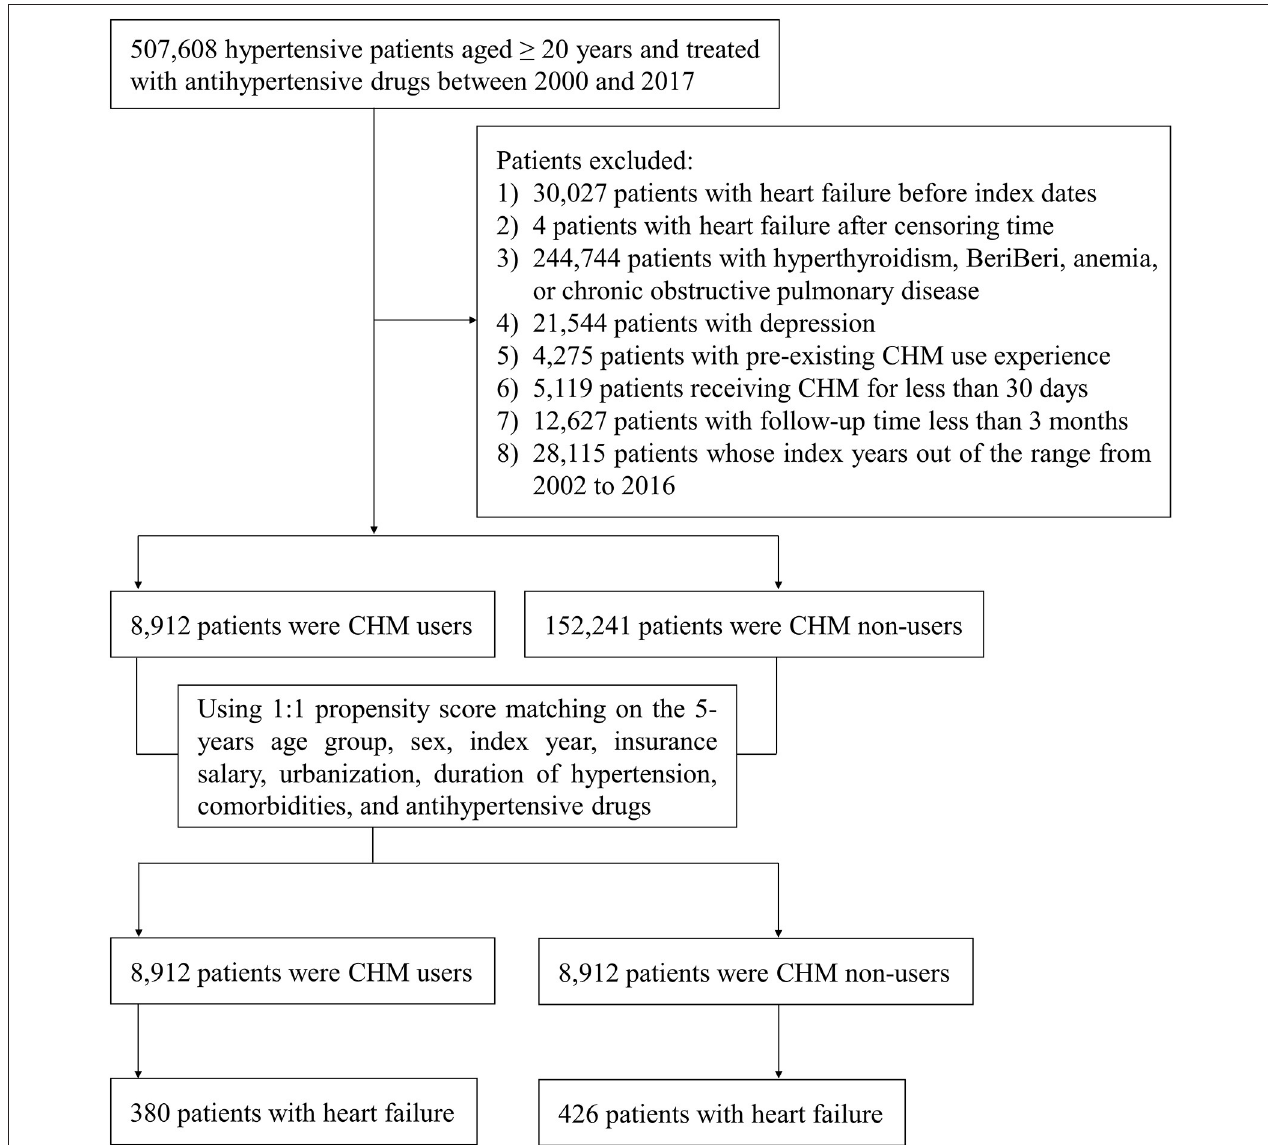
FIGURE 1 | Flowchart of the study participant selection.